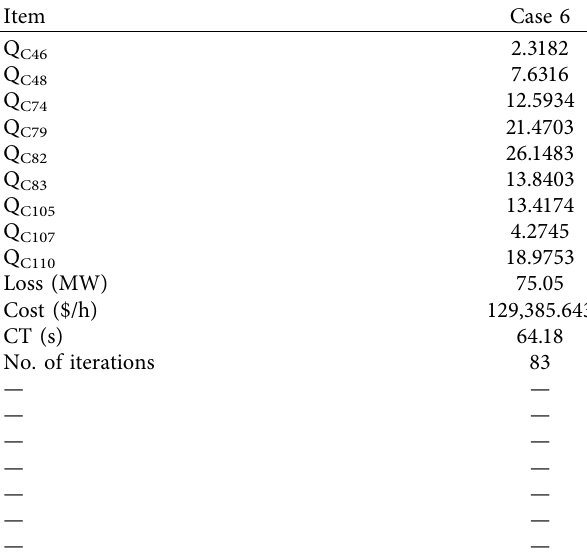
Table 11: Optimum solution obtained for case 7 using the chaotic Rao-2